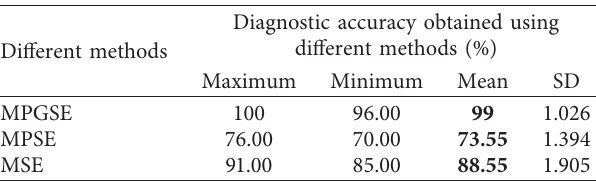
Figure 22: The plotting of the two randomly selected features in case 1. (a) MPGSE, (b) MPSE, and (c) MSE. Table 7: Diagnostic results of different methods without LS feature selection for the A dataset in case